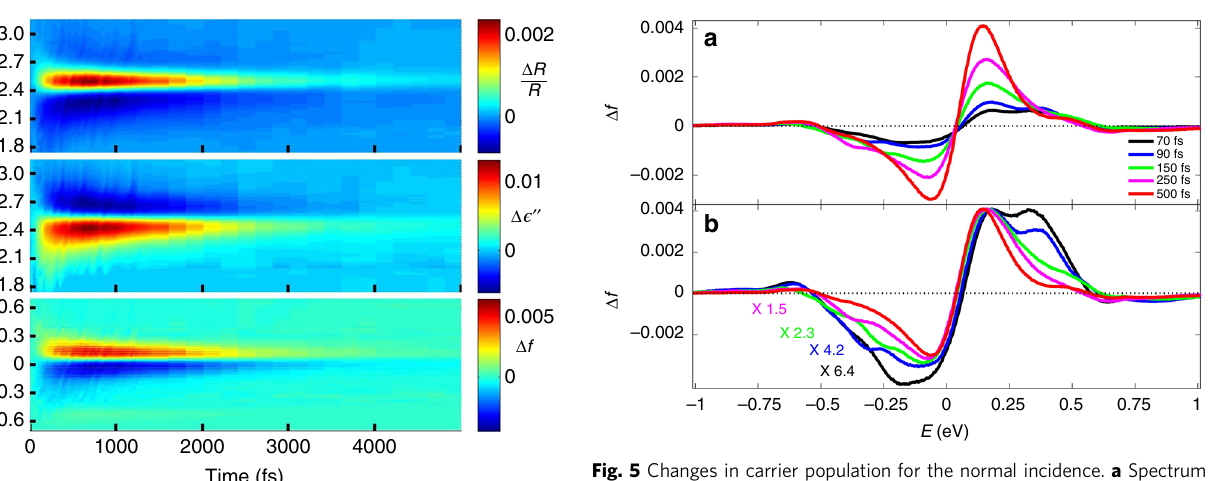
Fig. 3 Inversion of experimental pump-probe data. Maps show the changes in re fl ectivity, dielectric function and electron occupancy changes for the normal 30 nm con fi guration: a Δ R / R ( ħ ω ); b Δ ϵ ′′ ( ħ ω ) solved using the integral Eq. (2); c Δ f ( E ) solved using the second integral Eq. (4)